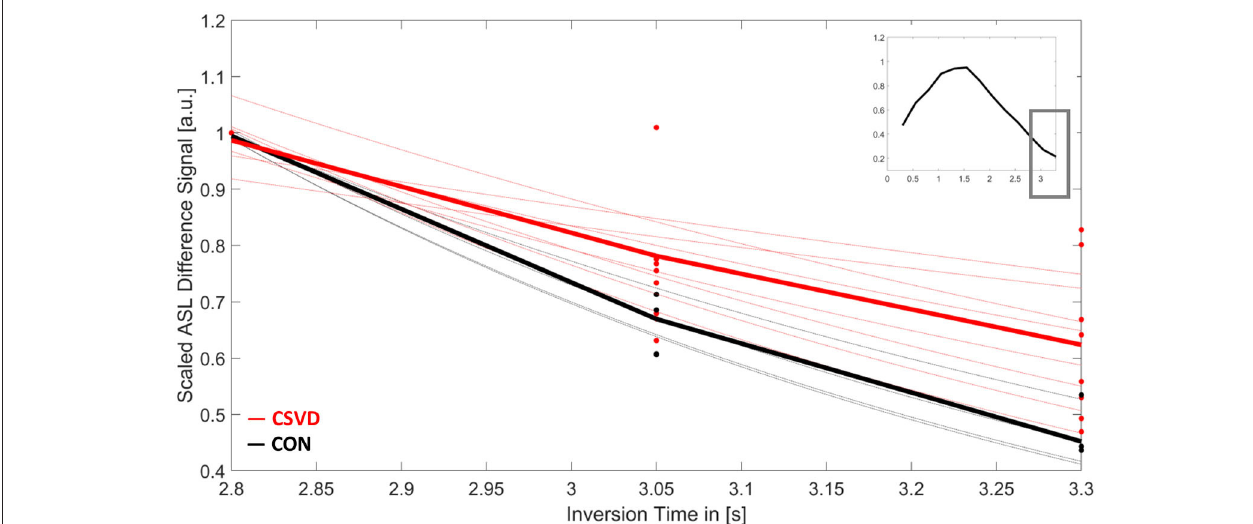
FIGURE 3 | Mean arterial spin labeling (ASL) signal decay of white matter over time for patients with cerebral small vessel disease (CSVD, red) and controls (CON, black). Shown is the scaled ASL difference signal for the last three inversion times (TI). Each dot represents the measured value of each participant at TI = 2,800/3,050/3,300ms. Thin lines show the results for the individual signal fits. Bold lines are the mean signal decays for both study groups. The small image in the upper right corner shows the mean-scaled ASL difference signal of all participants for the whole ASL time series.